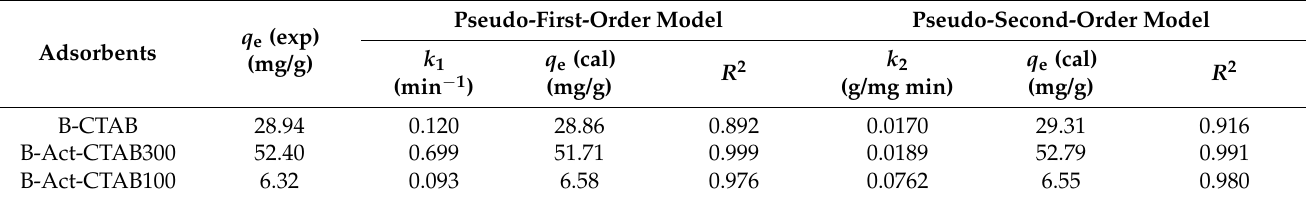
Table 4. Kinetic constants for pseudo-first- and pseudo-second-order models for OG dye adsorption on B-CTAB, B-Act-CTAB100 and